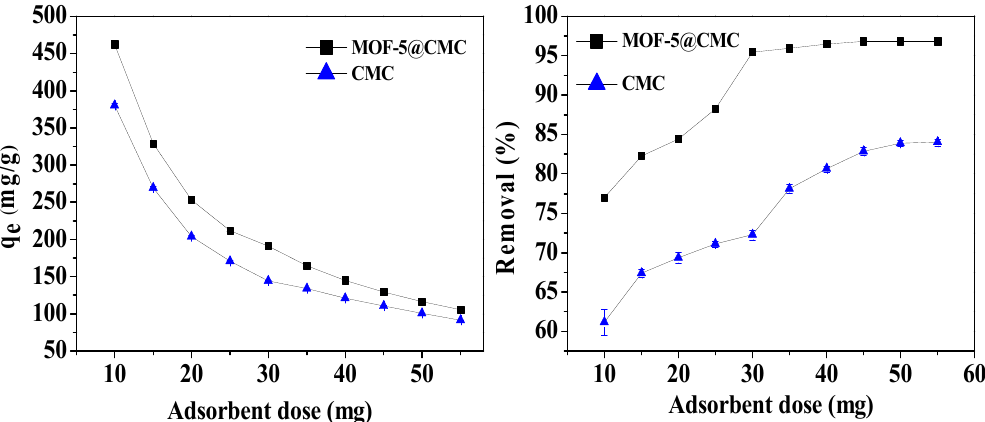
Figure 10. Adsorption capacity and removal rate as functions of adsorbent dose.